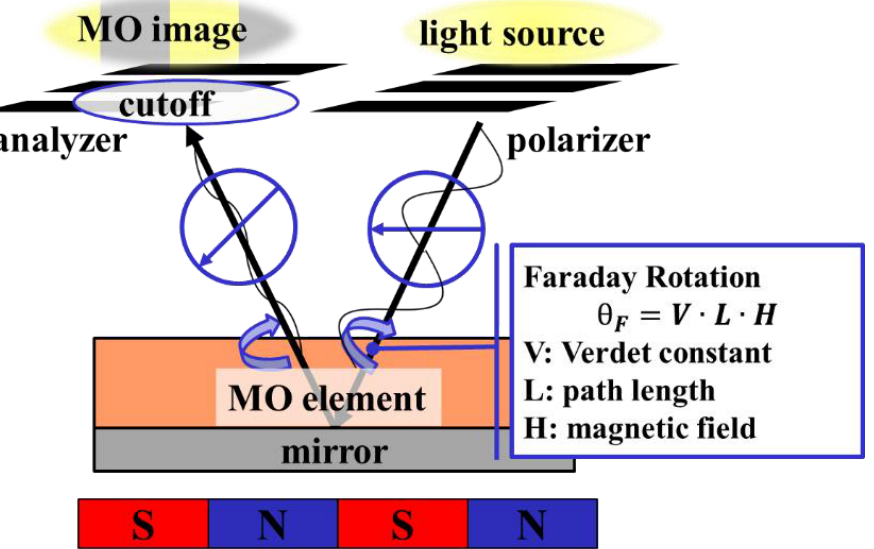
Figure 1. Principle of the magneto-optical sensor, which visualizes the magnetic flux density. Rotation angle of linearly polarized light is proportional to the strength of the magnetic field. Rotated polarized light is cuto ff by an analyzer according to its